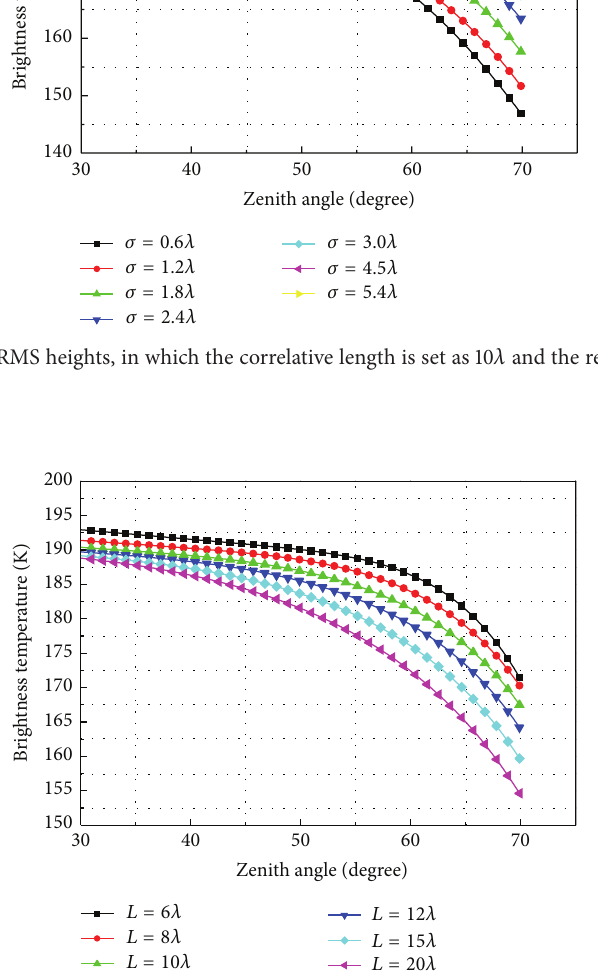
Figure 16: Comparison of different correlative lengths, in which the RMS height is set as 3 𝜆 and the relative complex permittivity is set as (3.2,